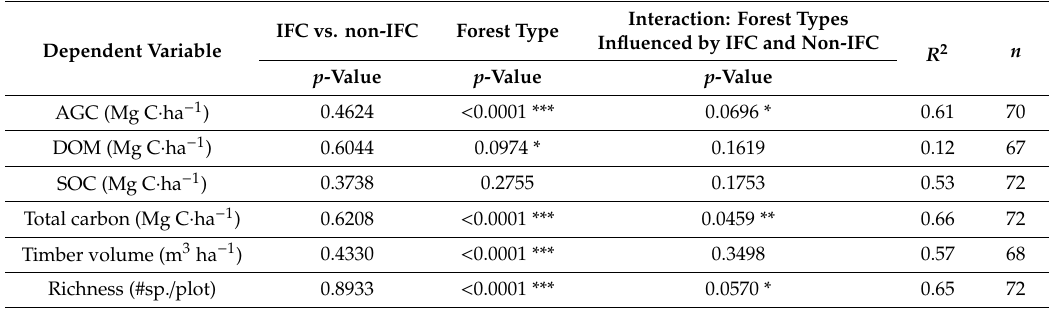
Table 2. Analysis of variance for carbon stocks, timber volume and species richness.